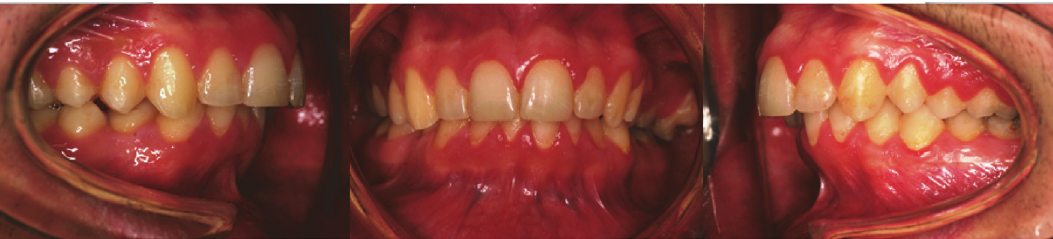
Figure 2: Intraoral occlusion before treatment.